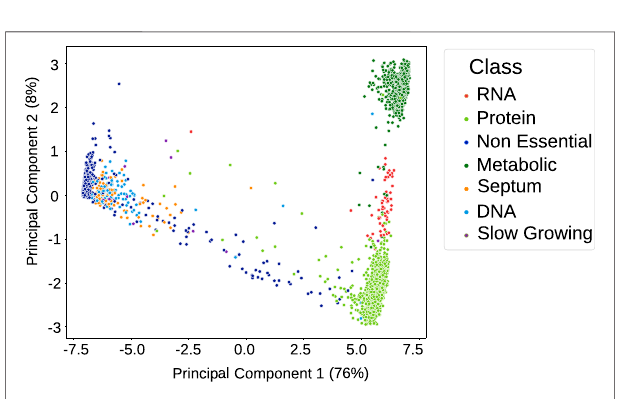
FIGURE 3 | Principal component analysis (PCA) plot of the fl ux pro fi les (binary strings of normal vs. abnormal classi fi cations for each fl ux in a simulation) from 3,411 gene knockout simulations, reduced to two dimensions (while retaining 84.5% of the variance) and then shown in different colours that correspond to manual labels. The classes are de fi ned by the presumed root cause of lack of cell division; or if the cell divides, the simulation is classi fi ed as